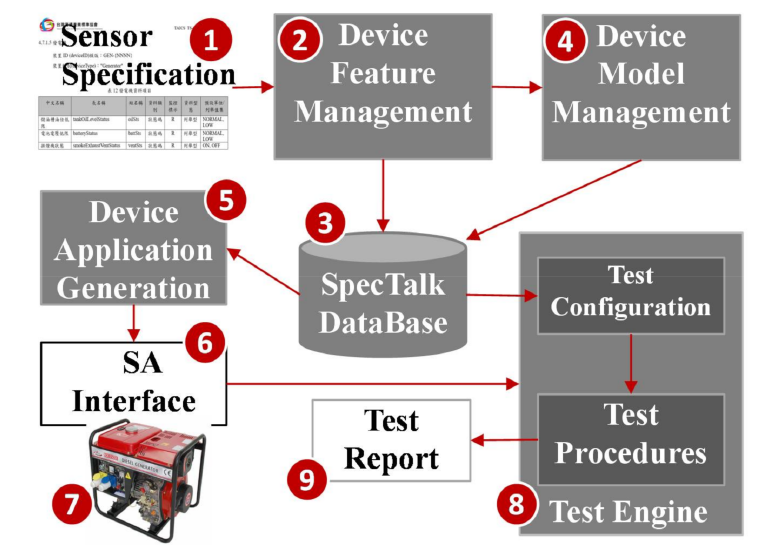
Figure 2. The SpecTalk approach to test an IoT device with TAICS